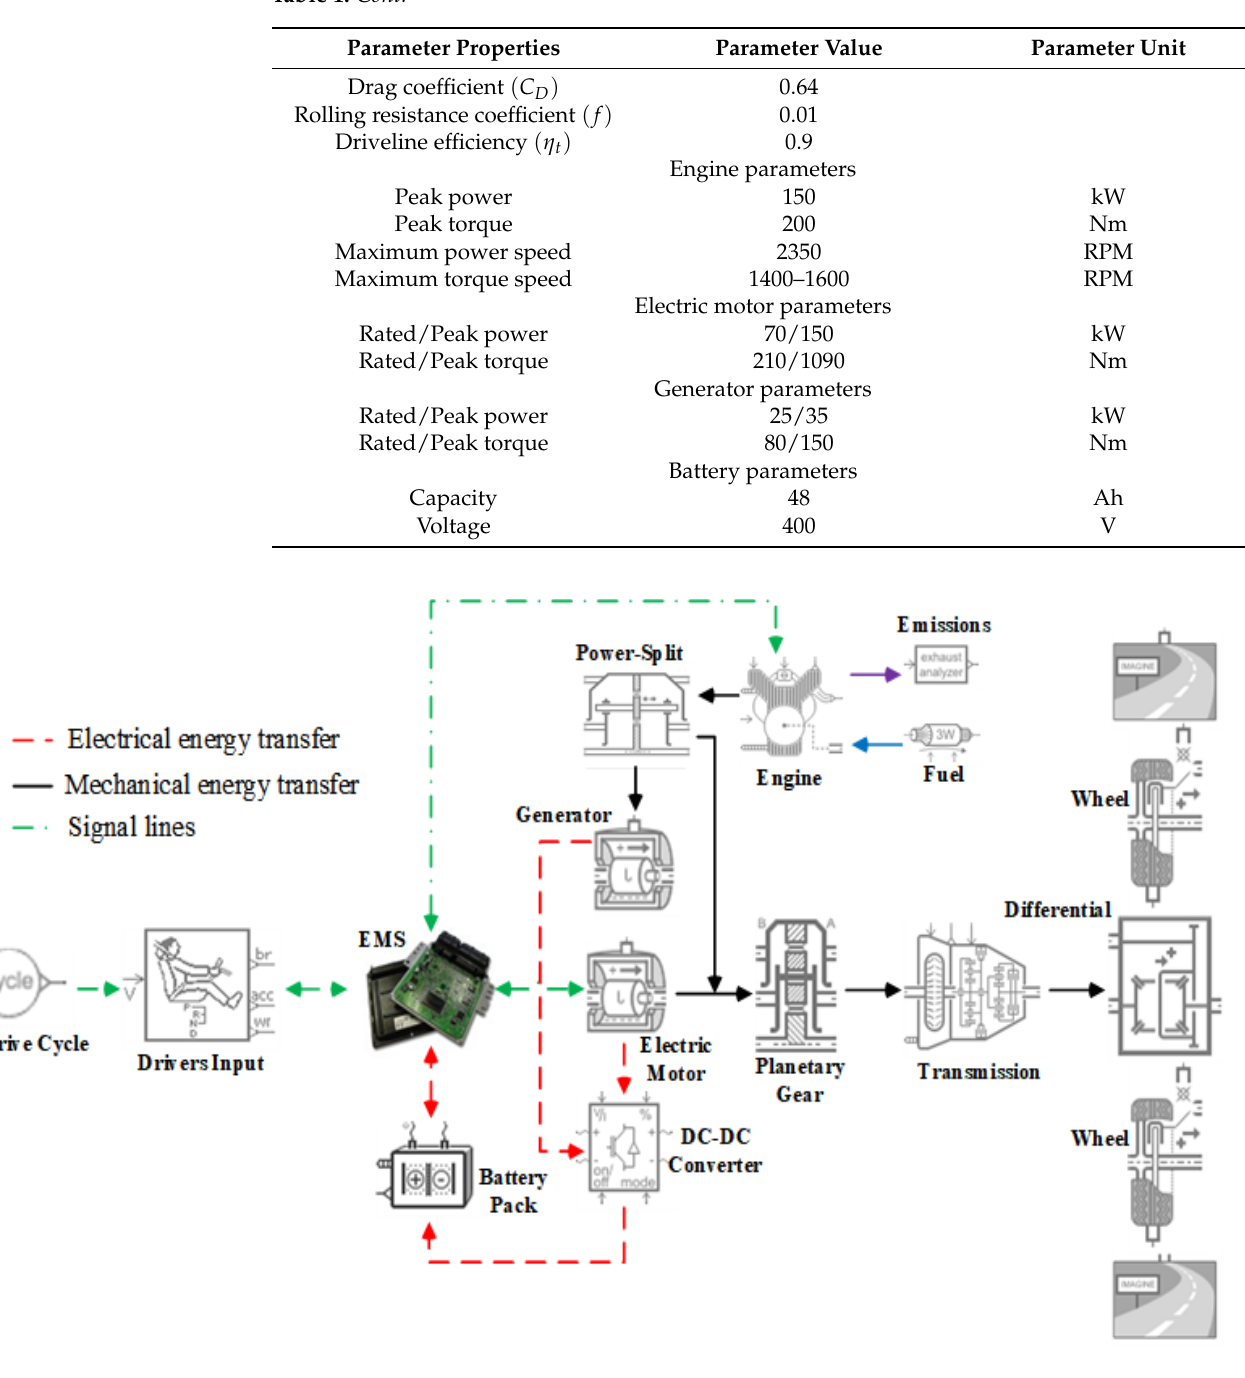
Figure 1. Topology of a power-split parallel hybrid electric powertrain system. Table 1. Basic parameters of the HE-ERV.